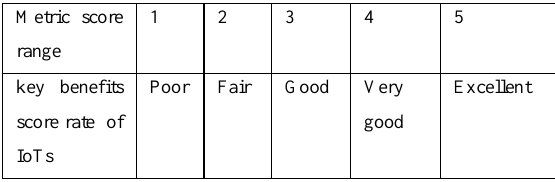
Table 1. Metric range and key benefits score rate of IoTs. Source: Owner